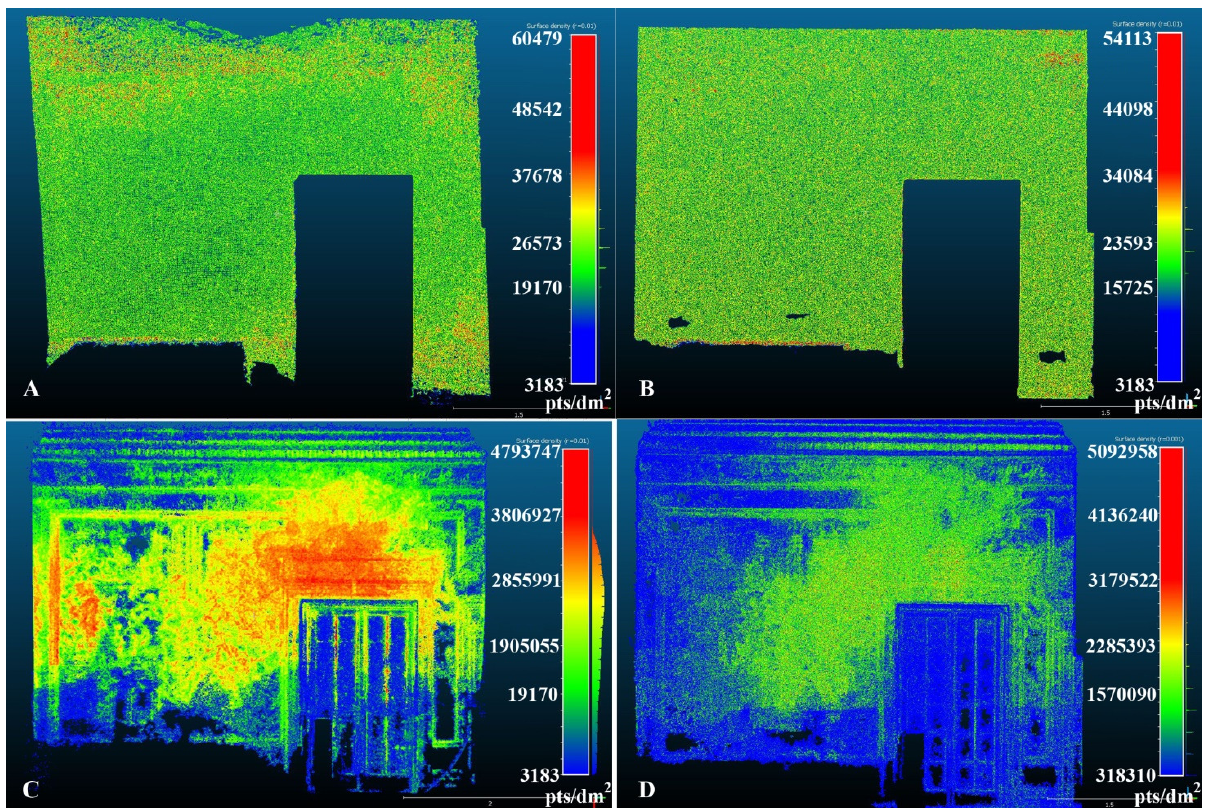
Figure 7. Map of point density distribution (search radius 0.01 m): a) Xiaomi Yi 2k, b) Xiaomi Yi 4k, c) Hasselblad Hd-50, d) Canon 5D Mark